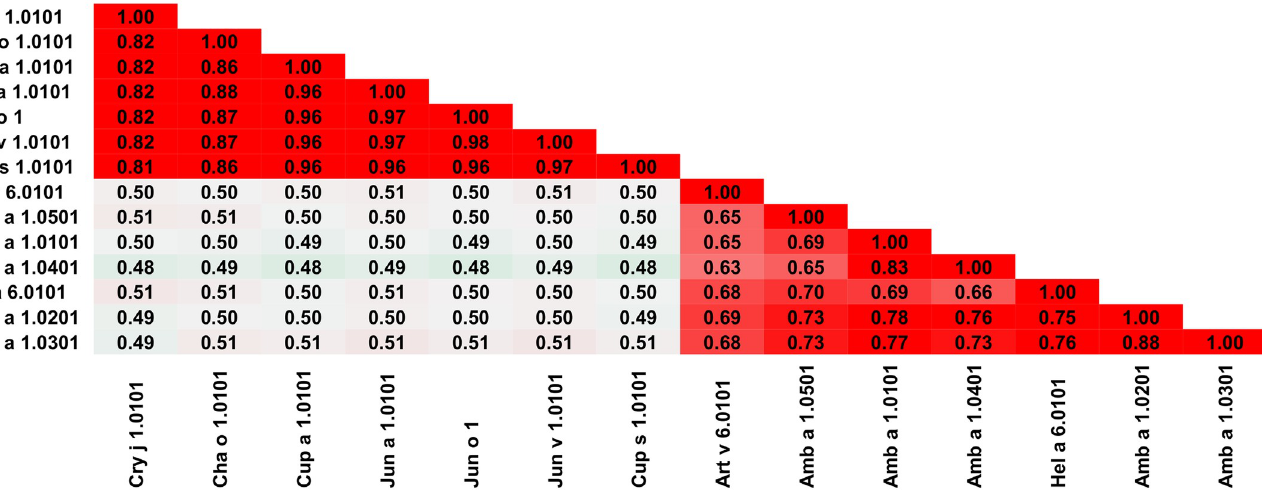
Fig 9. Plot showing A-RISC index values for allergen pairs from the pectate lyase family of proteins. Red color indicates a high risk of cross-reactivity, a dark green color indicates a low risk of cross-reactivity, and intermediate colors correspond to a medium risk of cross-reactivity.